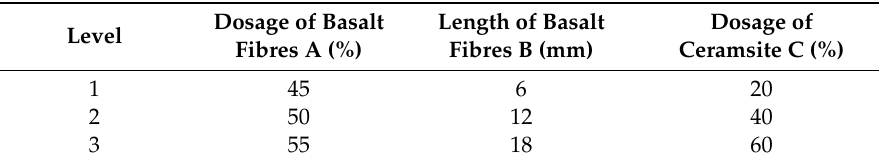
Table 1. Factors and levels of the orthogonal tests.